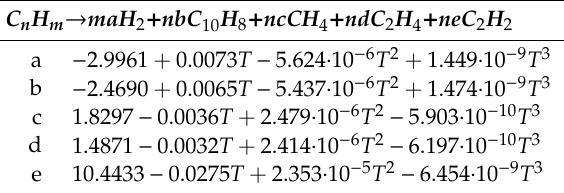
Table 1. Stoichiometric coe ffi cients of reaction 1.